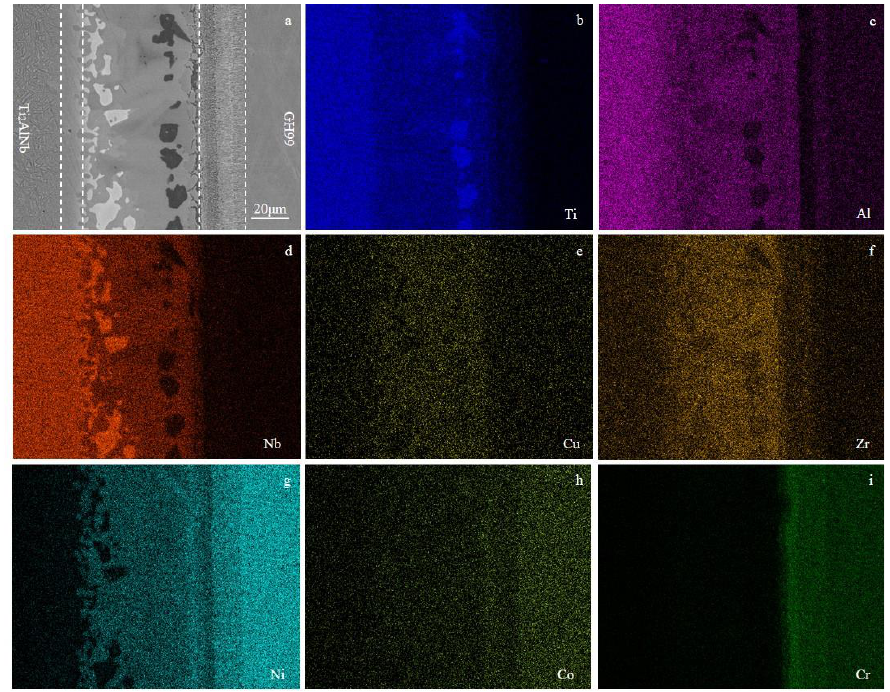
Figure 3. Element distribution maps of the Ti 2 AlNb/GH99 joint brazed at 1000 °C for 8 min. The typical interfacial microstructure of the brazed joint is illustrated in Figure 4.